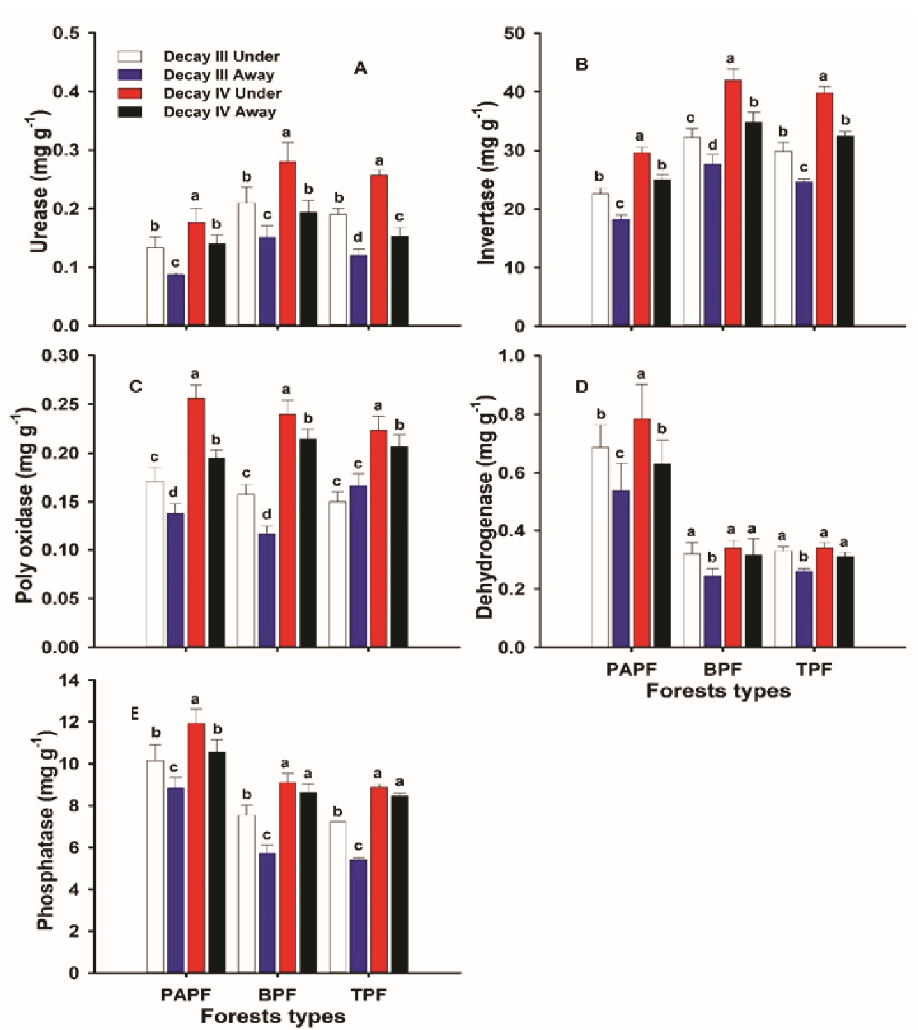
Figure 5. Urease (mg g -1 ) ( A ), invertase (mg g -1 ) ( B ), poly oxidase (mg g -1 ) ( C ), dehydrogenase (mg kg -1 ) ( D ) and phosphatase (mg kg -1 ) ( E ) concentrations of the same dominant tree species PK with different decay classes at different distances in contrasting forest types of PAPF, BPF and TPF in northeastern China. Significant changes between treatments within the same forest type are denoted by various lowercase letters. Tukey’s honest significant difference (HSD) post hoc; p < 0.05, mean ± SE = 3; the bars show standard errors.